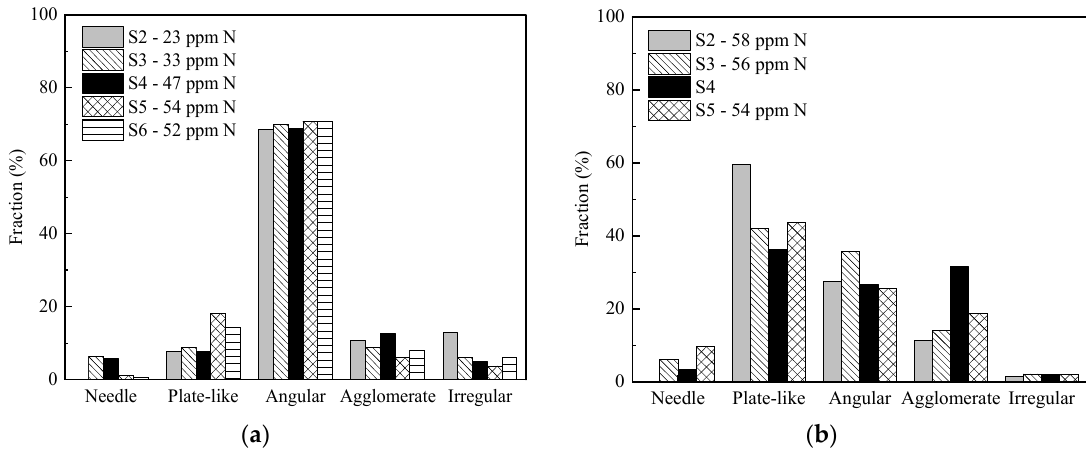
Figure 9. The fraction of morphology of AlN (pure) inclusions in ( a ) 533N-P and ( b ) 533N-I steel melts.